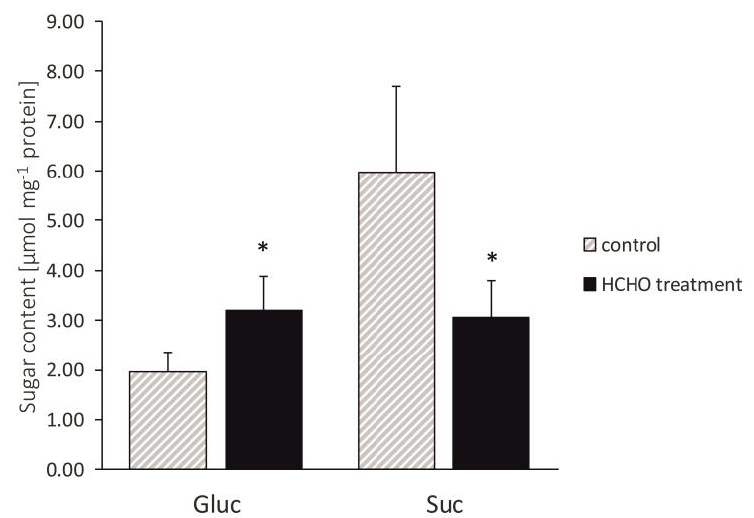
Figure 2. Effect of treatment with gaseous formaldehyde applied as 20 mg m − 3 on Gluc and Suc contents in C. comosum leaf tissues after 48 h of plant exposure. Data are means ± SD. * indicates values that differ significantly from the control at p < 0.05.